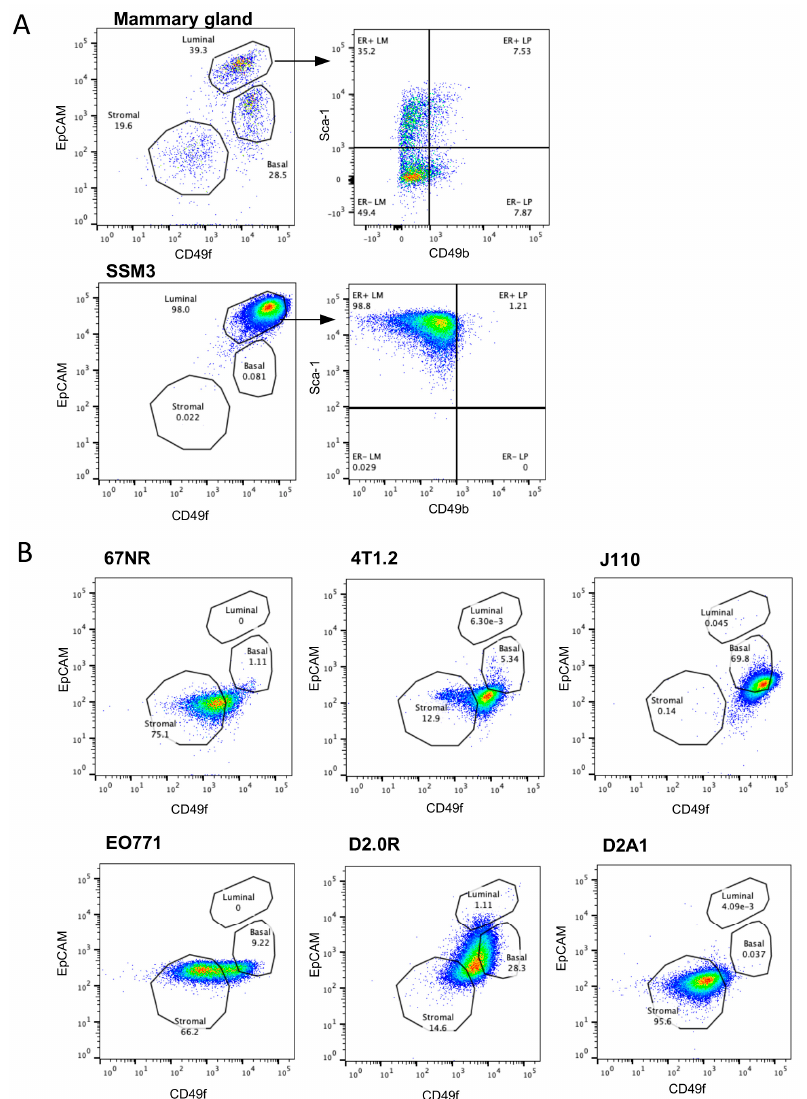
Figure 5. FACS profiles of syngeneic cell lines. Cells were grown in a culture and then assessed using flow cytometry markers for mammary epithelial cell subpopulations. FACS plots shown have already been gated to remove doublets, dead cells (PI positive) and lineage cells (CD45-, CD31-, TER119-). ( A ) Plots show a normal mouse mammary epithelial cell profile. EpCAM and CD49f delineate luminal, basal and stromal cells. Specific luminal cell populations can be further resolved using CD49b and Sca1. SSM3 cells are shown here as a luminal ER + cell line. ( B ) Resolution of the epithelial cell subpopulations in six other mammary tumour lines. (LM, luminal mature; LP, luminal